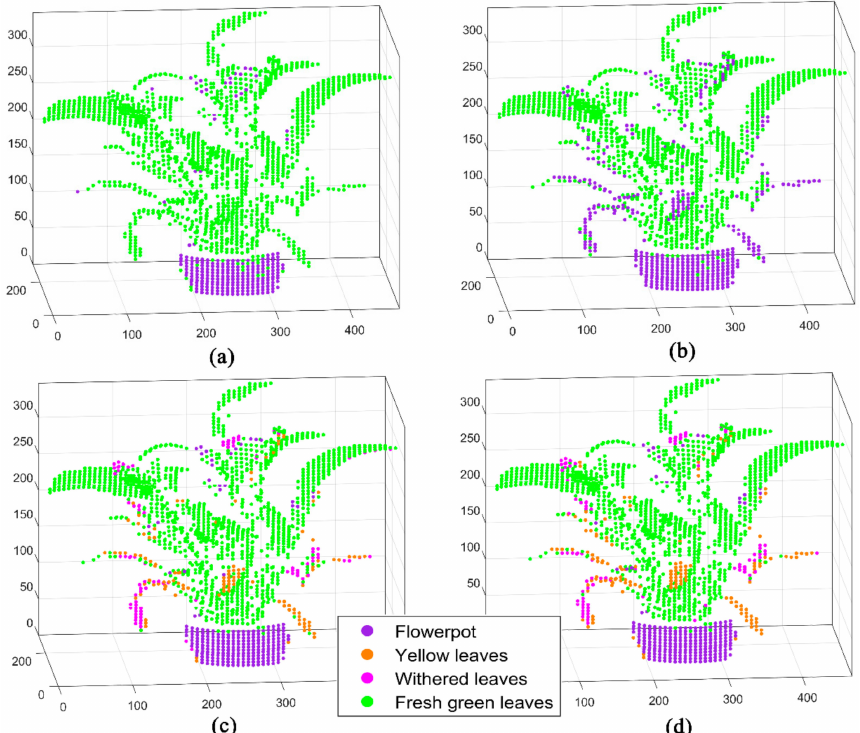
Figure 9. Di ff erent wavelength spectral data classification result graphs based on the MWFL system scanning in Scene 2. ( a ) Single-wavelength (460 nm); ( b ) Single-wavelength (685 nm); ( c ) Double-wavelength (460 nm + 685 nm); ( d ) Four-wavelength intensity data for